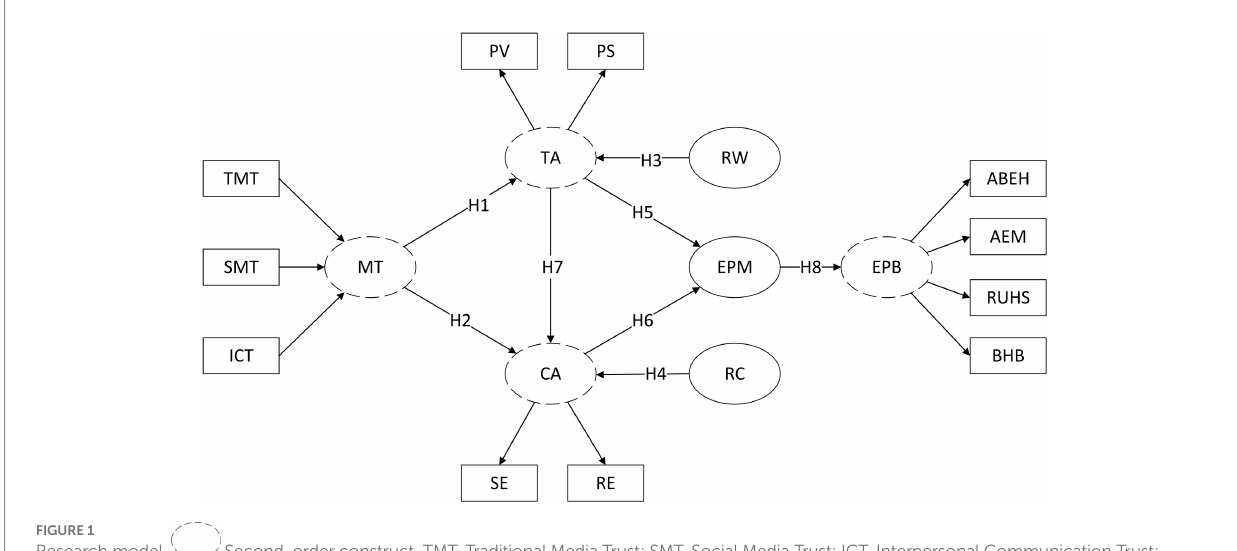
FIGURE 1 Research